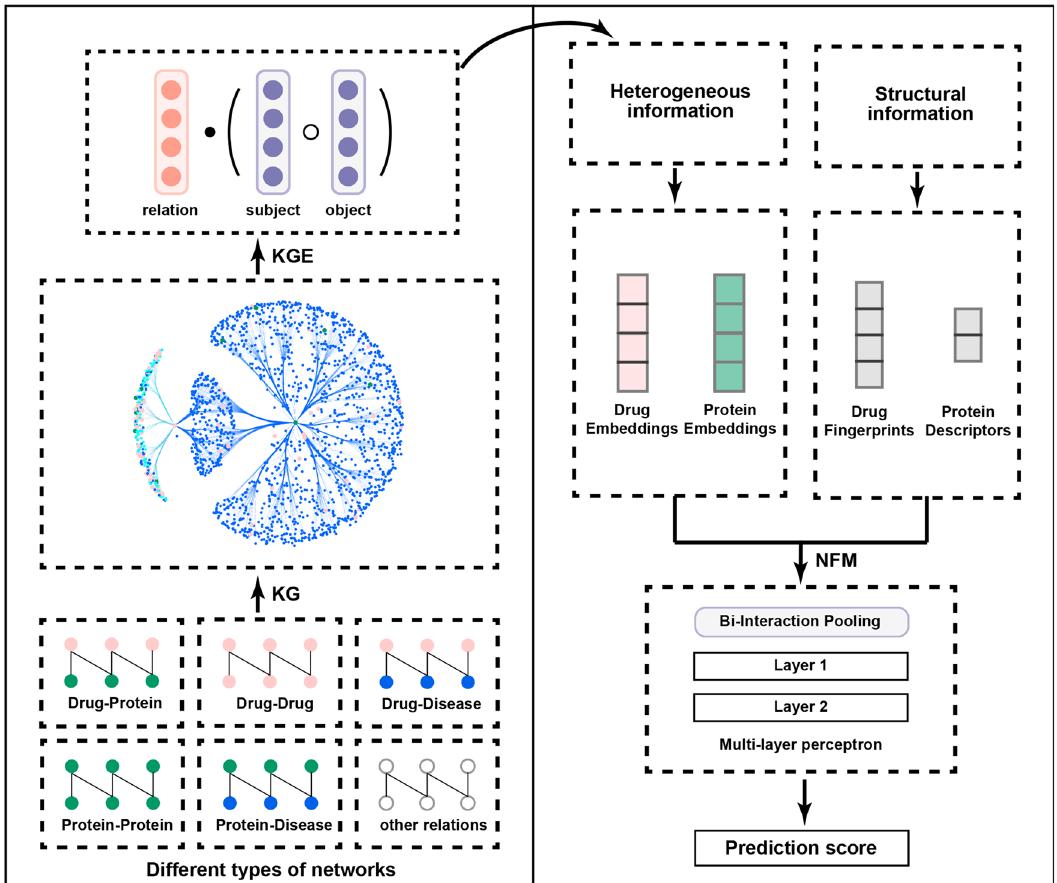
Fig. 1 The schematic work fl ow of KGE_NFM. The pipeline mainly consists of two parts. (1) The construction of KG and embeddings extraction. The original input contains the DTI data and related omics data, and the embeddings of entities and relations are extracted by DistMult. (2) The integration of multimodal information by NFM. The extracted KGEs represent the heterogeneous information, and the molecular fi ngerprints and protein descriptors represent the structural information. The two types of information are combined and optimized via the Bi-Interaction layer and a feed-forward neural network (FFNN) is used to capture the inherent correlations between